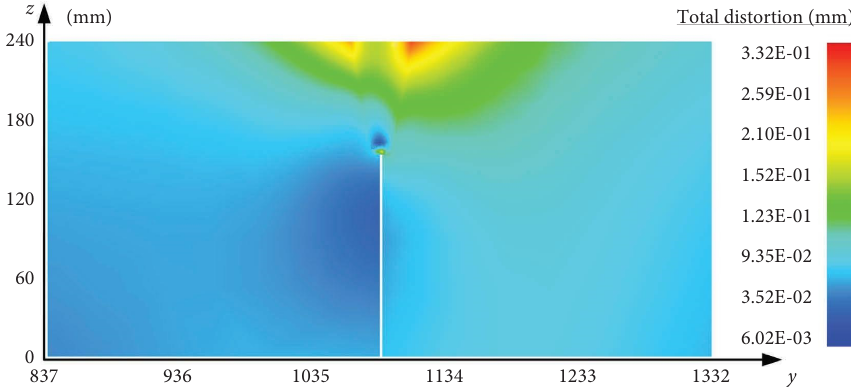
Figure 6: Total deformation of the antenna’s azimuth